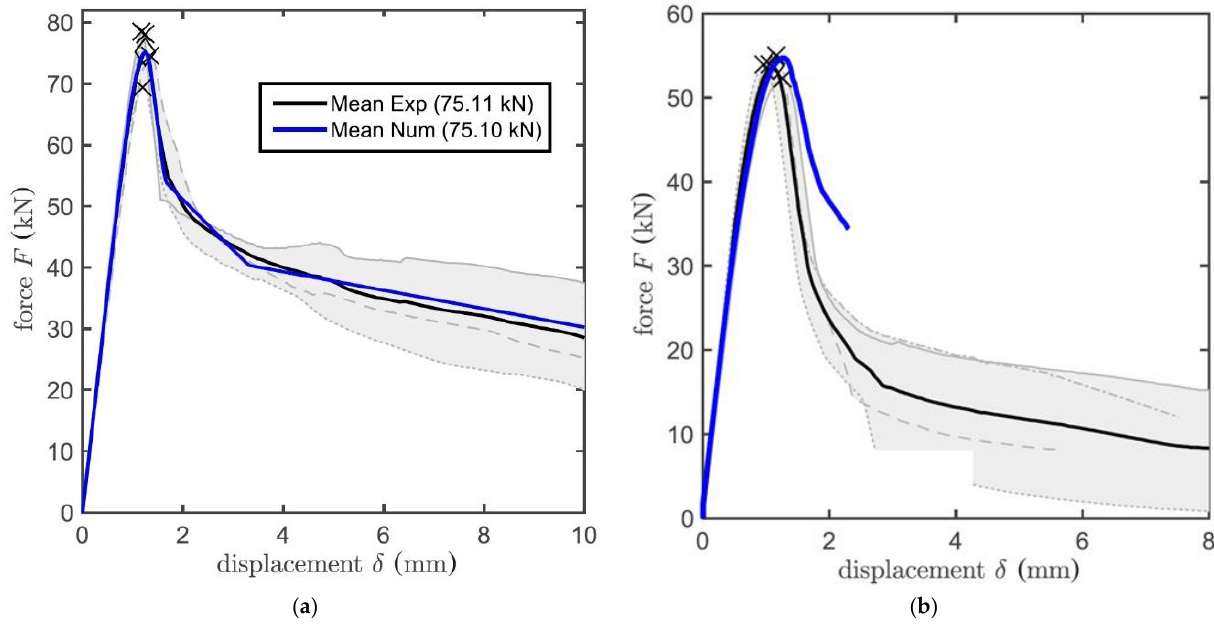
Figure 3. The example of post-peak behaviour of adhesive anchor — experiment (black) and the numerical model (blue); ( a ) Confined test; ( b ) Unconfined test [25].